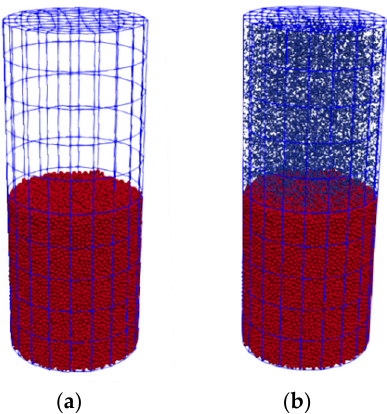
Figure 5. Generation of sand column and slurry particles: ( a ) sand column, ( b ) slurry particles.